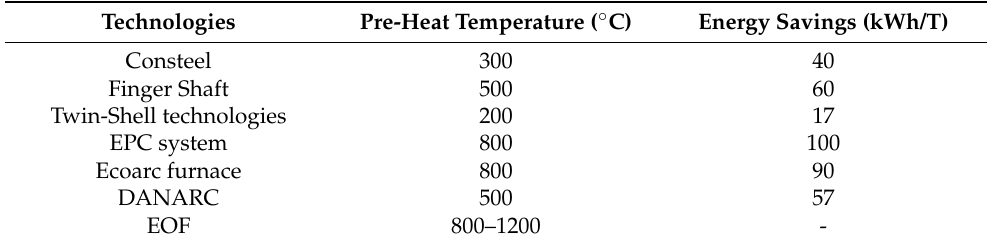
Table 4. Scrap pre-heating technologies used in steelmaking process. Data from [49–53].